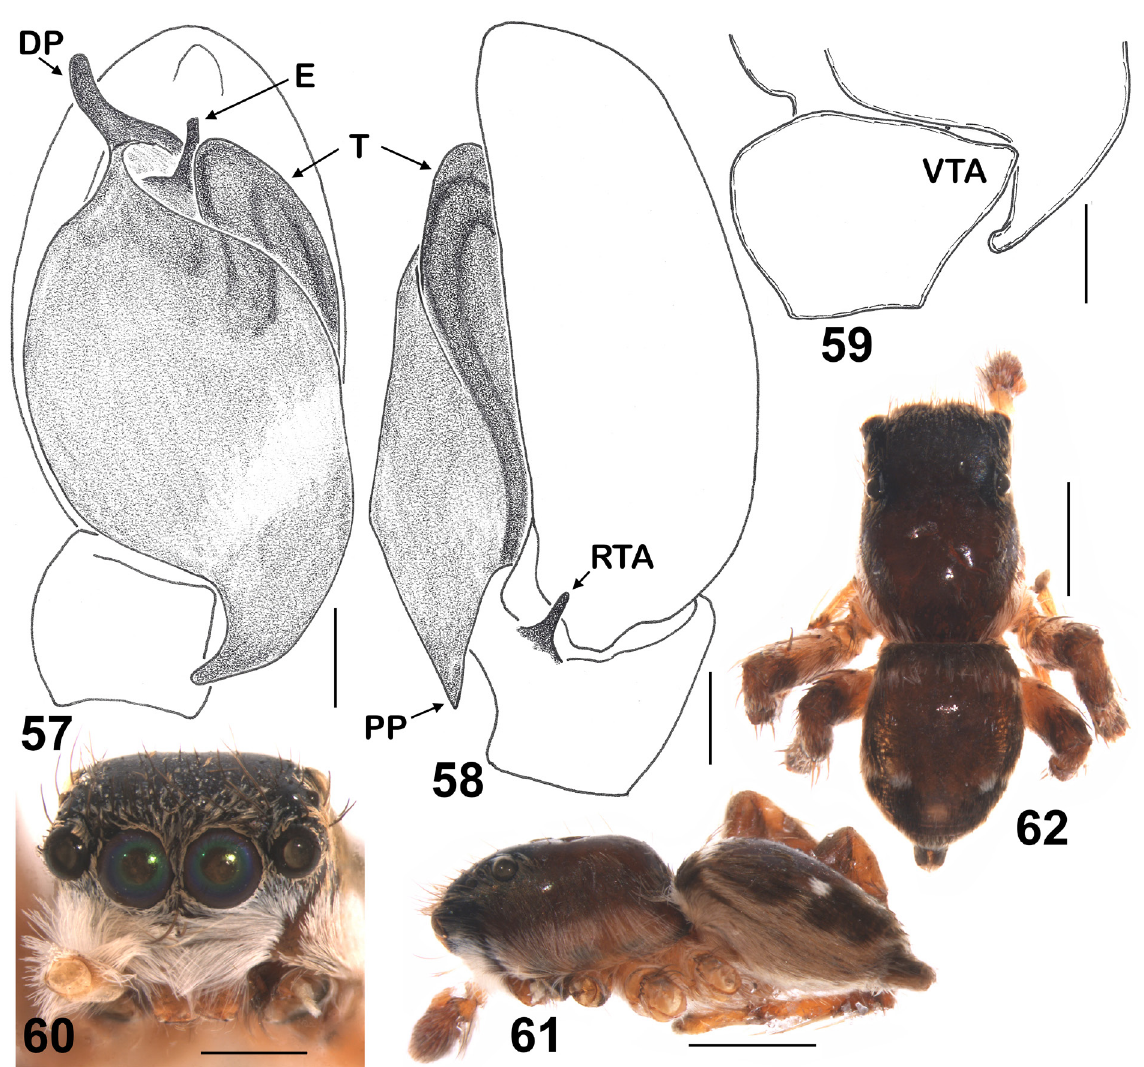
Figs 57–62. Stenaelurillus arambagensis (Biswas & Biswas, 1992), ♂ from Pakistan (Jehlum) . 57 . Male palp, ventral view. 58 . Male palp, retrolateral view. 59 . VTA, median view. 60 . Clypeus, front view. 61 . Body, lateral view. 62 . Body, dorsal view. Abbreviations: see Material and methods. Scale bars: 57–59 = 0.1 mm; 60 = 0.5 mm; 61–62 =